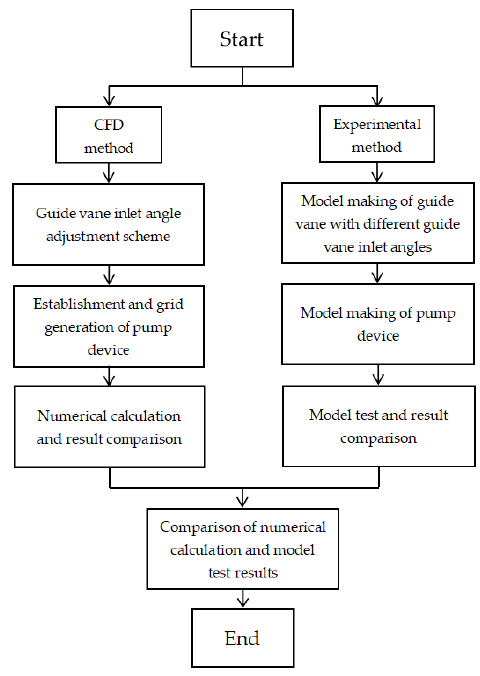
Figure 5. Flow chart of the main steps for research.